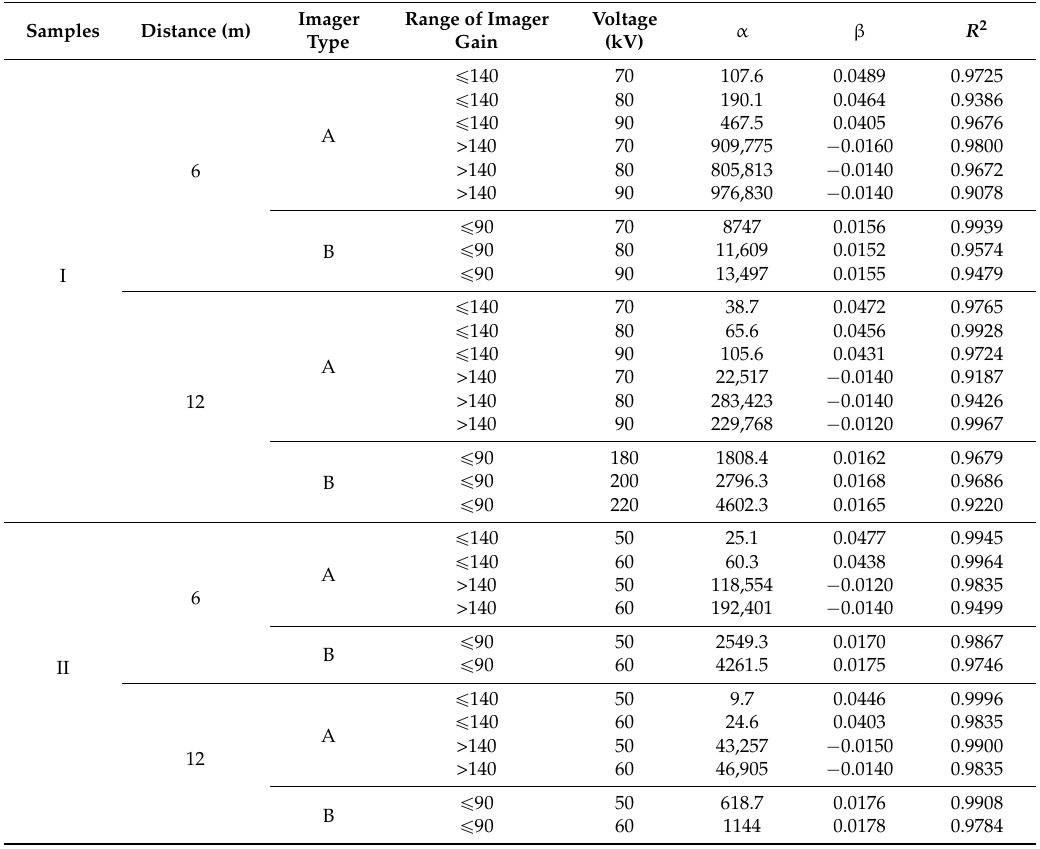
Table 4. Fitting parameters of imager gains to photon numbers.